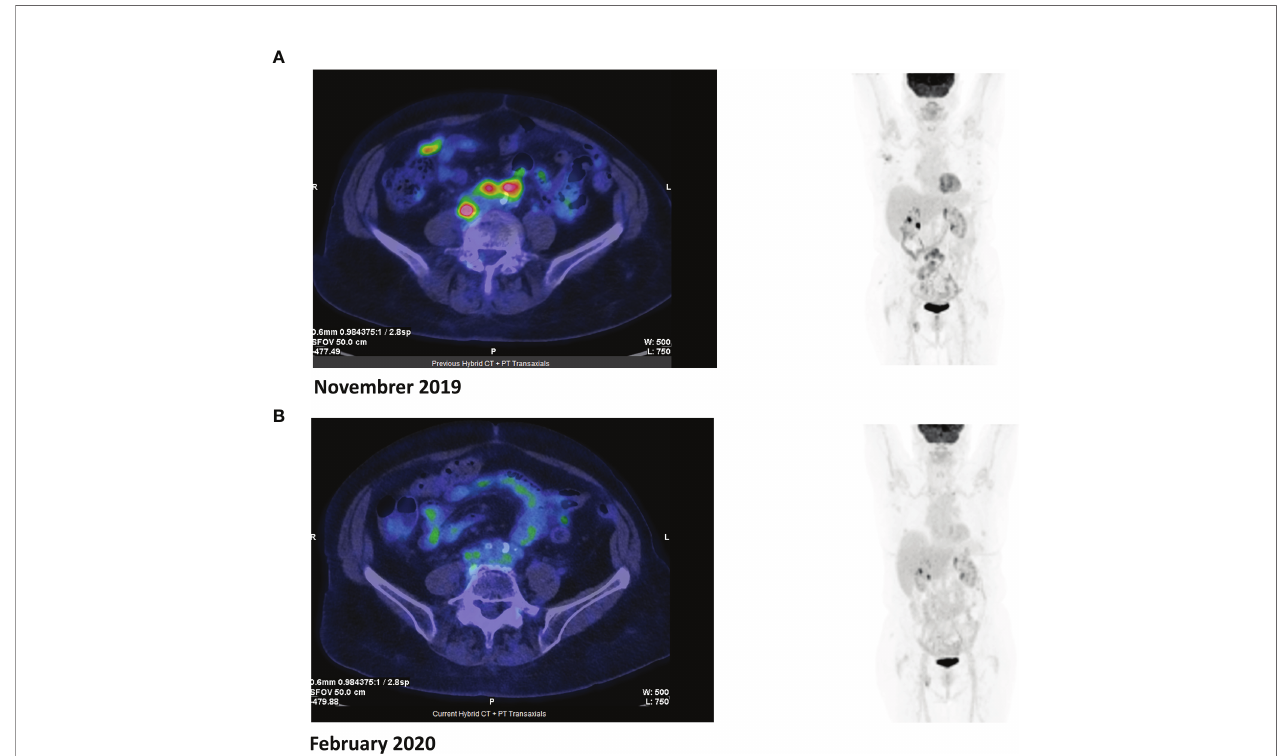
FIGURE 1 | Positron emission tomography (PET) images before (A) and after (B) three cycles of venetoclax.